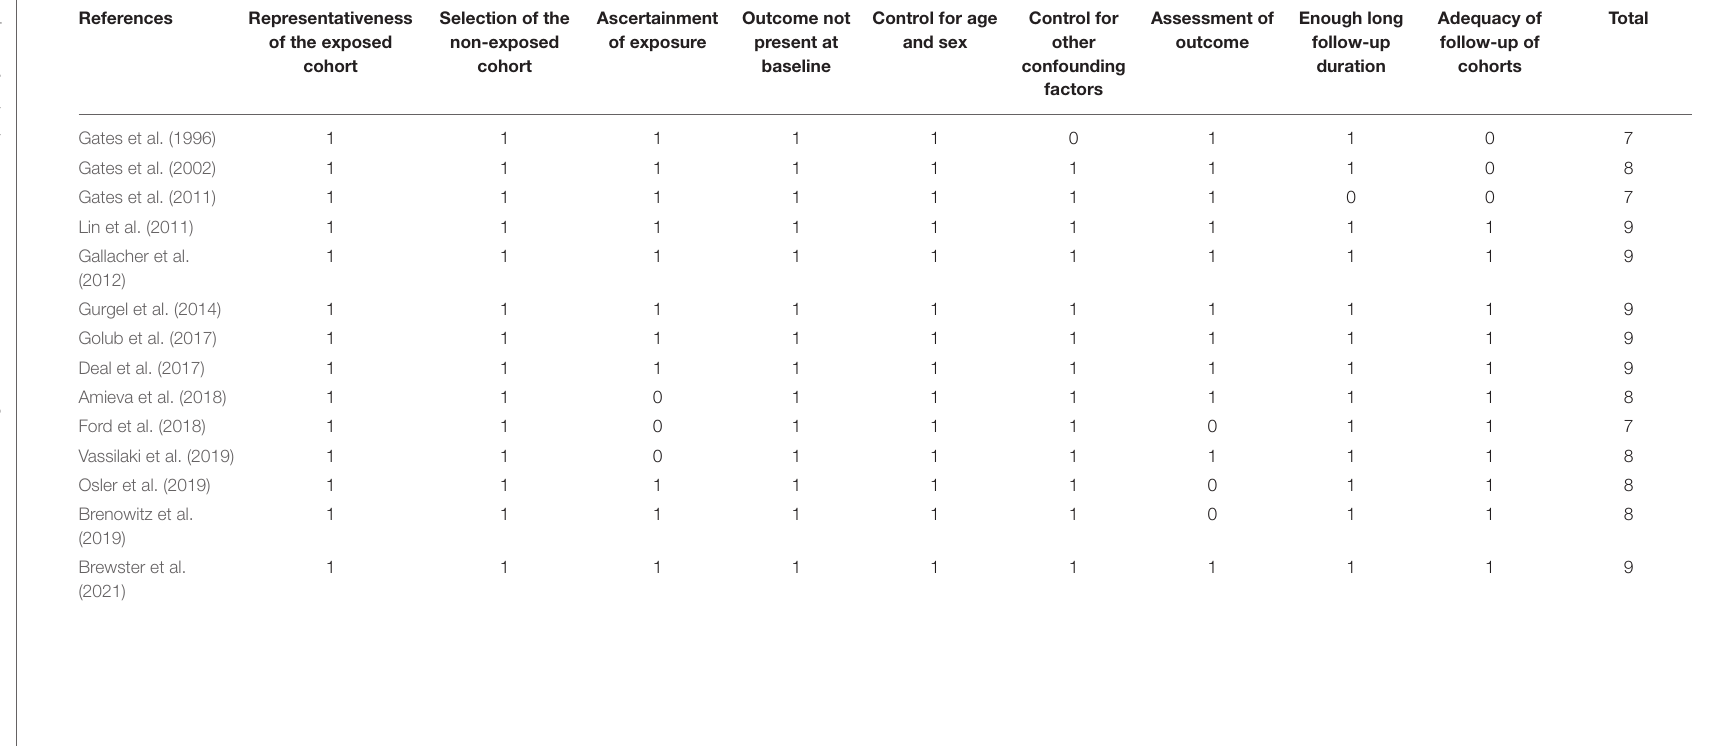
TABLE 2 | Details of quality evaluation via the Newcastle–Ottawa